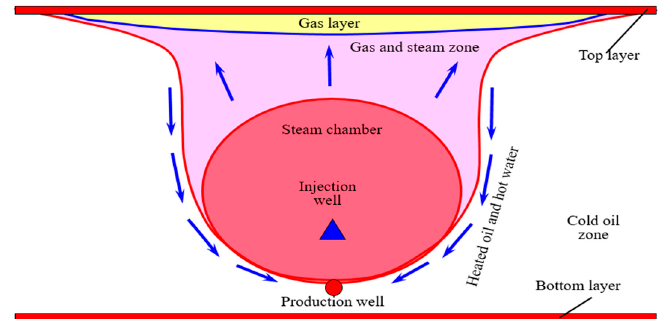
Figure 6. Schematic diagram of SAGP injection.